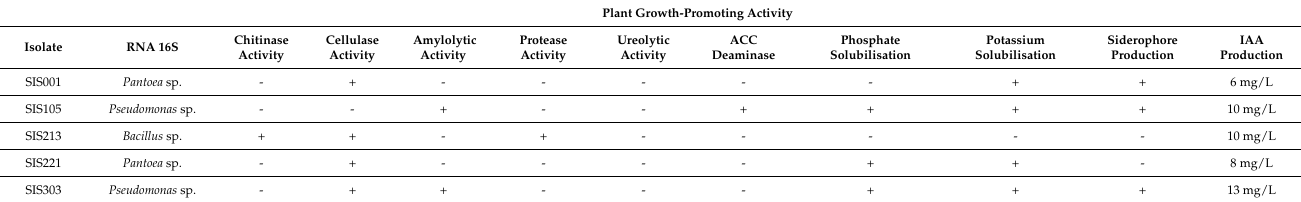
Table 1. Plant growth-promoting activities of the five selected isolated bacterial strains.